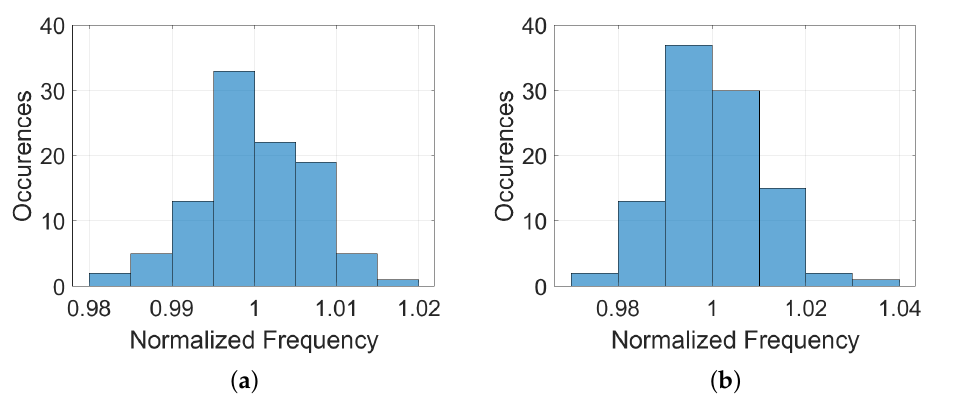
Figure 14. Histogram of the ( a ) lower and ( b ) higher cut-off frequency of the last stage of circuit 1. Both frequencies are normalized with respect to the mean of all 100 Monte Carlo samples of each respective frequency.